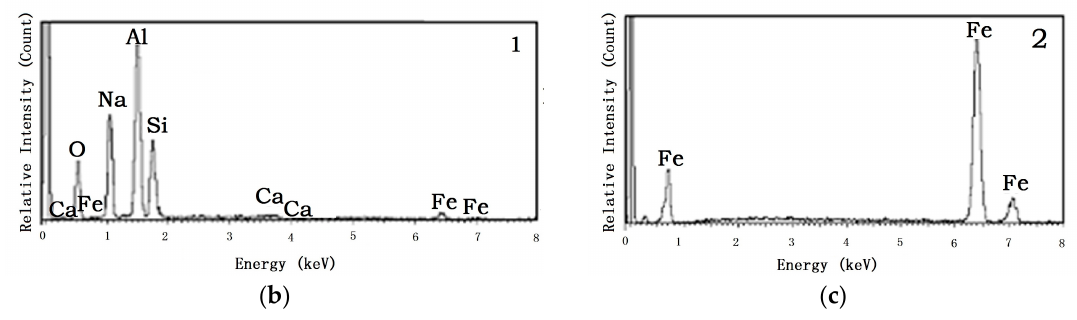
Figure 11. ( a ) SEM image of iron powder; ( b ) EDS image of point 1 and ( c ) EDS image of point 2.